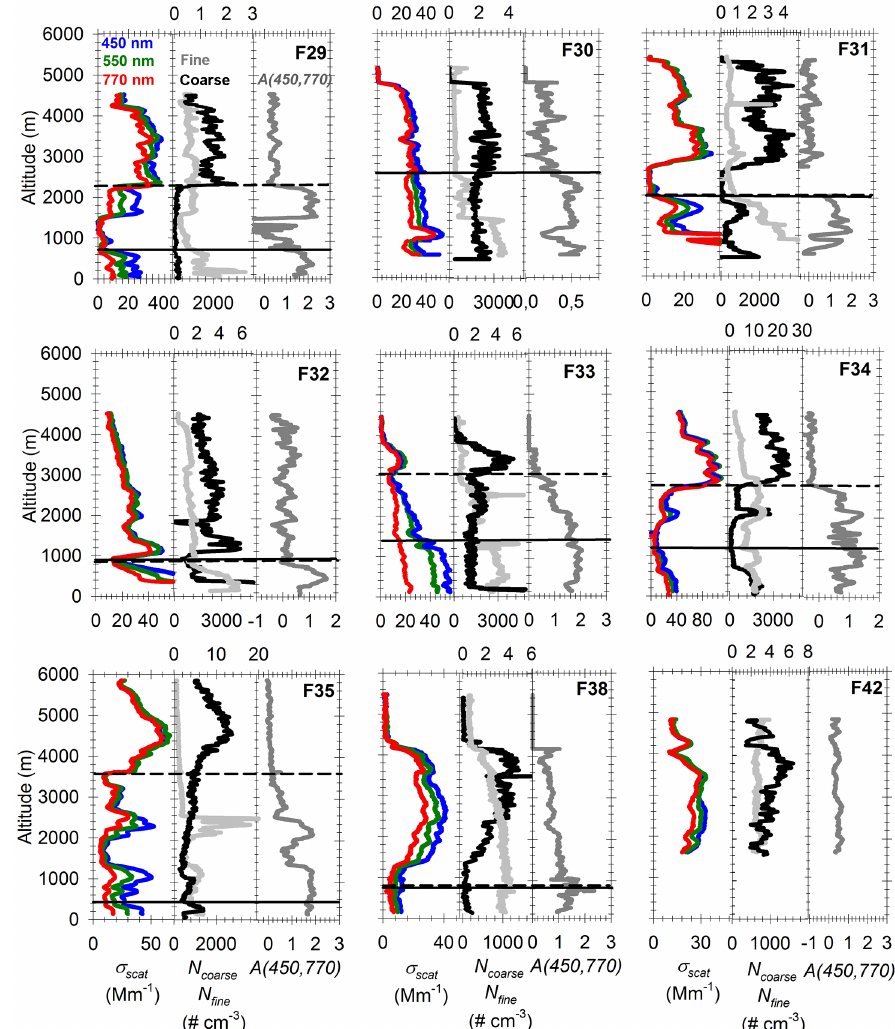
Figure 5. Vertical profiles of the aerosol scattering coefficient σ scat at λ = 450, 550 and 770nm (blue, green and red), the particle number concentration in the submicron N fine (light grey) and the supermicron N coarse (dark) size ranges and the scattering Ångström exponent Å calculated between 450 and 770nm (dark grey). N coarse is plotted using the upper horizontal axis. The top of the boundary-layer Z b and the wind shear level Z s are indicated by a horizontal and dashed line respectively. The height of Z b was situated below the minimum flight level in F30 and F42. The height of Z s was situated below the minimum flight level in F42. Data were corrected for standard temperature and pressure using T = 20 ◦ C and P =